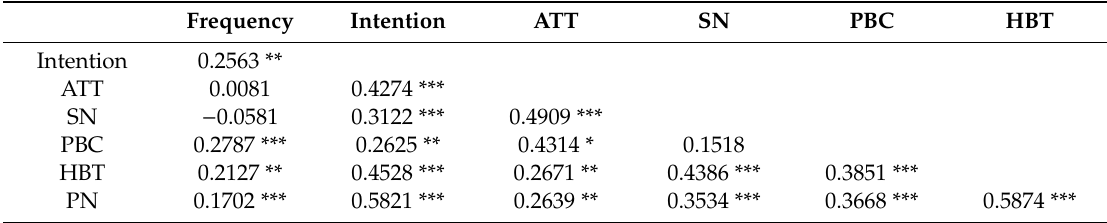
Table A2. Correlation between TPB constructs, perceived need, and habit for meat consumption ( n = 86).